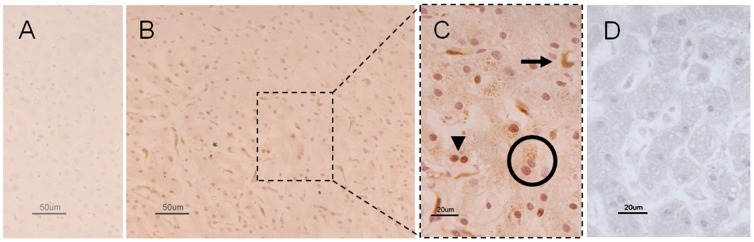
Representative photomicrographs showing TP immunoreactivity in control and MNGIE liver.
Figure 2A demonstrates the lack of TP immunolabeling in a normal liver section in which the primary antibody was omitted (negative control). Figure 2B (low magnification) and 2C (high magnification) illustrate TP immunoreactivity in a normal liver section. In Figure 2C, the arrowhead and circle, (Figure 2C) point to TP immunostained nuclei and cytoplasm of hepatocytes, while the arrow indicates non-hepatocytic cells with features of bile duct elements. Also, note the lack of any TP immunolabeling in a MNGIE liver section (Figure 2D). Calibration bars  = 20 µm and 50 µm in 2C, 2D and 2A, 2B, respectively.